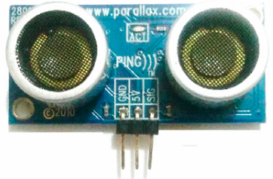
Figure 3. Physical shape of ultrasonic PING